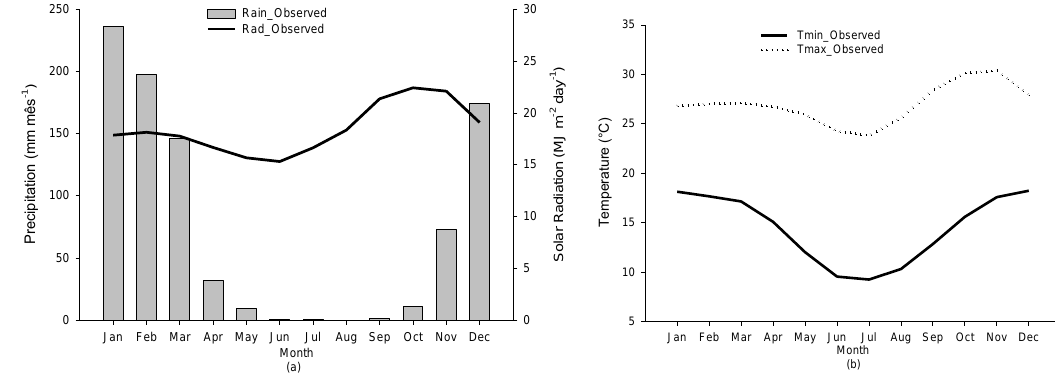
Figure 1. ( a ) average monthly rainfall and solar radiation; ( b ) maximum and minimum temperature observed (1980–2010).